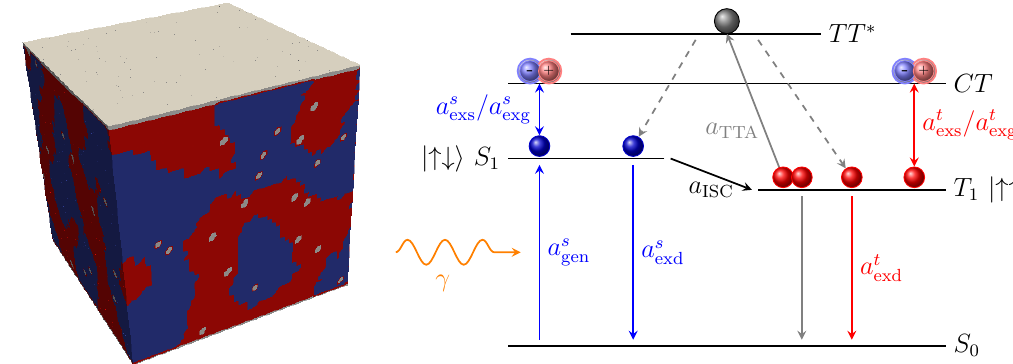
Figure 5. (Left) Bulk-heterojunction including dopant sites with a volume concentration of 0.8vol %. (Right) Jablonski diagram illustrating the exciton transitions. All processes considering triplet excitons are visualized in red color, while singlet transitions are highlighted in blue. The diagram shows the lowest excited singlet ( S 1 ) and lowest excited triplet state ( T 1 ), the singlet ground state ( S 0 ) and charge transfer state ( CT ). Our excitonic model consists of the optical singlet exciton generation ( a s gen ) upon the absorption of an incident photon γ , singlet/triplet exciton separation ( a s / t exs ), electrical generation ( a s / t exg ) and decay ( a s / t ), triplet-triplet annihilation ( a TTA ) and intersystem crossing ( a ISC ). Two triplet exd excitons can annihilate with a rate a TTA forming an intermediate state TT ∗ , which relaxes to either the lowest singlet S 1 or lowest triplet state T 1